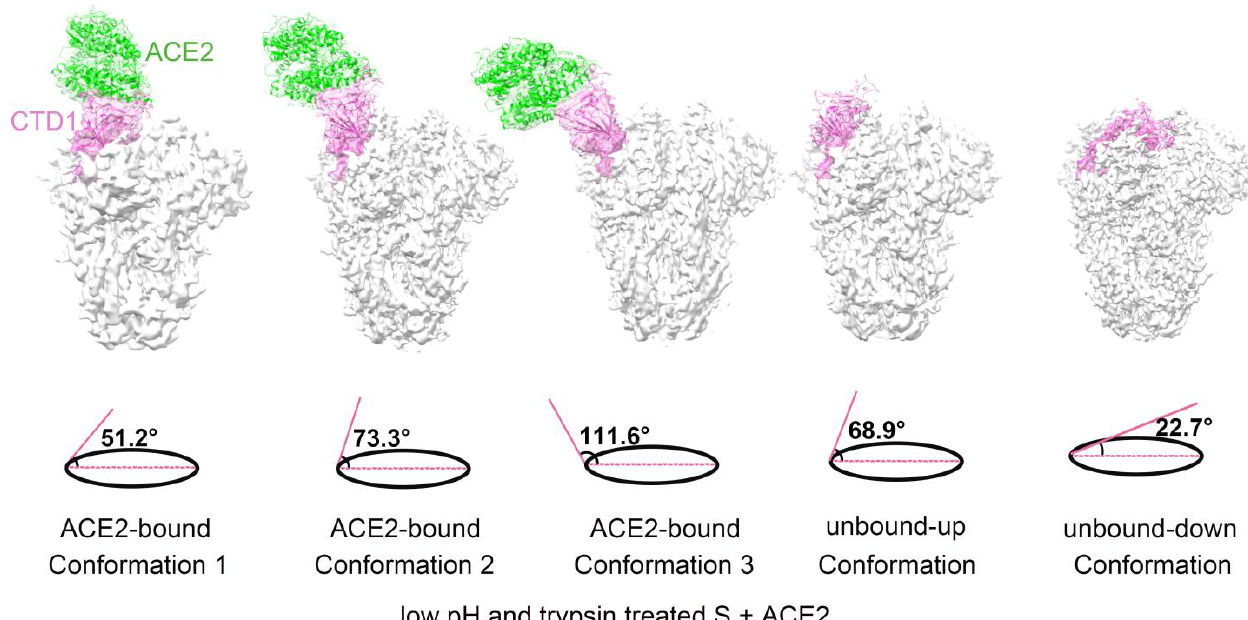
Figure 2: Courtesy reference number 24. GS-441524 and GS-5734 inhibit MHV with minimal cytotoxicity. (A) GS-441524 is a 1′- cyano 4-aza-7,9-dideazaadenosine C-adenosine nucleoside analogue. (B) Change in viral titer of MHV compared to vehicle control after treatment with GS-441524. The data represent the results from 2 independent experiments, each with 3 replicates. Error bars represent standard error of the mean (SEM). (C) Viral titer data from panel B presented as the percentage of uninhibited control. The EC 50 of GS-441524 was calculated to be 1.1 μM. (D) Cell viability normalized to the vehicle control after treatment with GS- 441524. The data represent the results from 3 independent experiments, each with 3 replicates. Error bars represent SEM. (E) GS- 5734 is a monophosphoramidate prodrug of GS-441524. (F) Change in viral titer of MHV compared to vehicle control after treatment with GS-5734. The data represent the results from 4 independent experiments, each with 3 replicates. Error bars represent SEM. (G) Viral titer data from panel F presented as the percentage of uninhibited control. The EC 50 of GS-5734 was calculated to be 0.03 μM. (H) Cell viability normalized to vehicle control after treatment with GS-5734. The data represent the results from 3 independent experiments, each with 3 replicates. Error bars represent